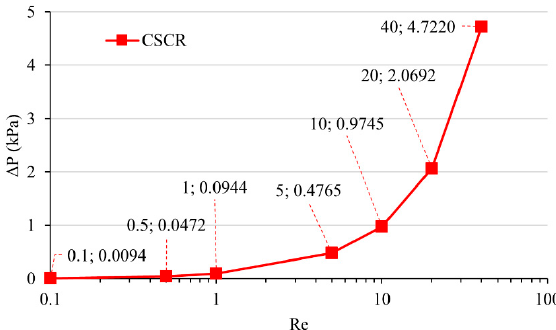
Figure 10. Pressure drop, ∆ P (kPa) vs. Reynolds number in the CSCR micromixer. The numbers before and after the semicolons represent Re number and pressure drop values respectively.